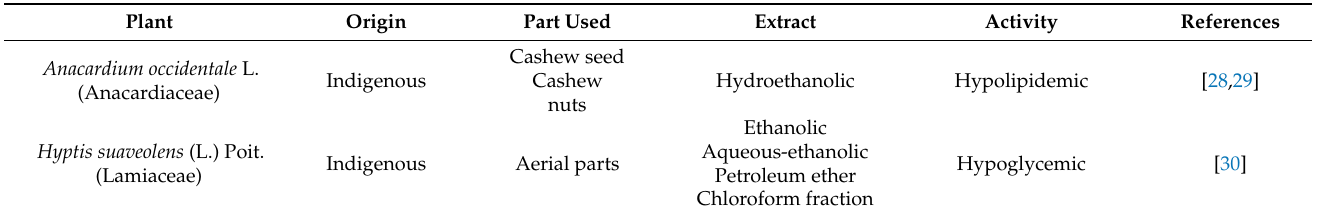
Table 1. General overview of plants from the Caribbean flora described in this review in which in vitro studies are available. Information about the origin, part of the plant used, type of extract, antidiabetic activity and references are